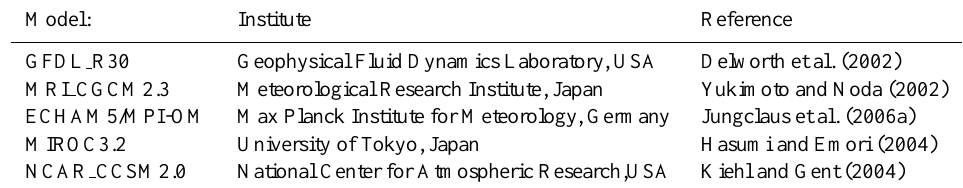
Table 1. List of the emulated AOGCMs.